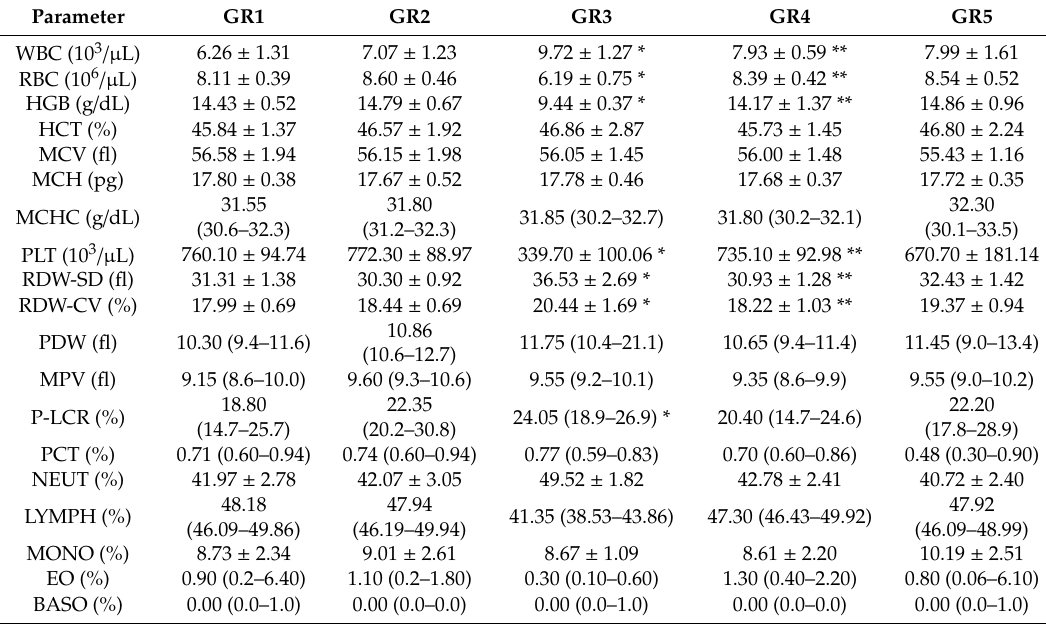
Table 2. Results of the hematology